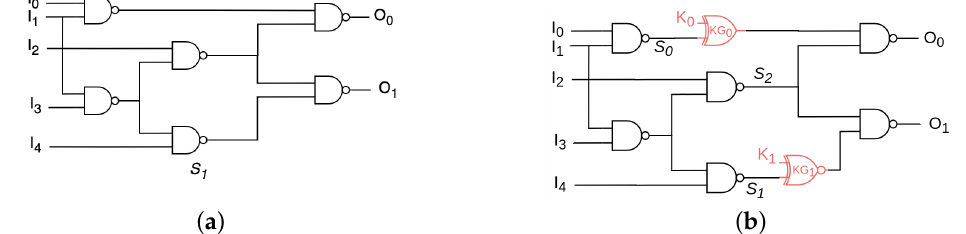
Figure 1. Logic locking technique: ( a ) original circuit, ( b ) key-gate insertion based logic